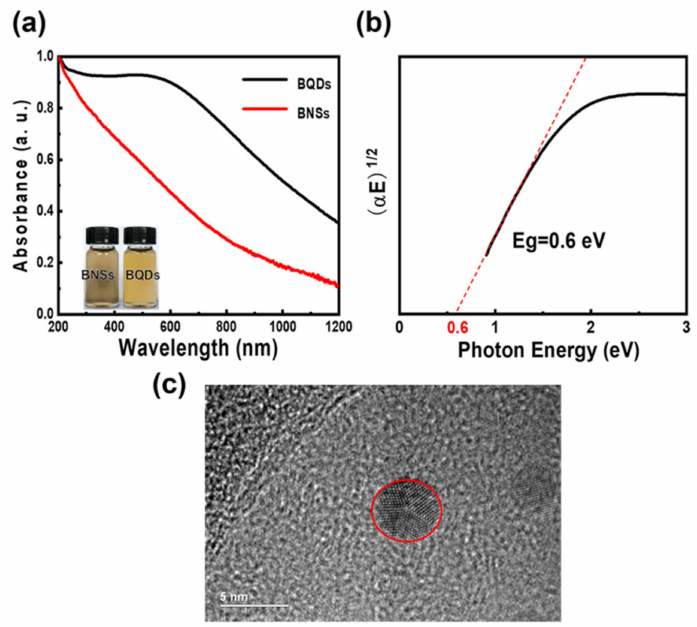
Figure 2. ( a ) UV-Vis-NIR absorption spectra of the BQDs and BNSs. ( b ) the corresponding optical band gap of BQDs. ( c ) the HRTEM image of BQDs with defects on